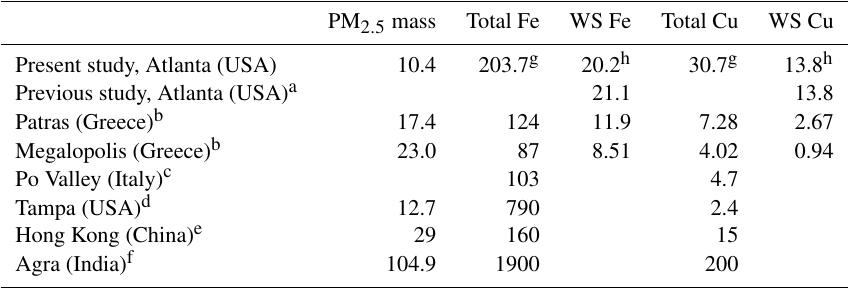
Table 3. Concentration of PM 2 . 5 particulates (µgm − 3 ) and transition metals (ngm − 3 ) in the ambient air of urban and suburban areas in different parts of the world.